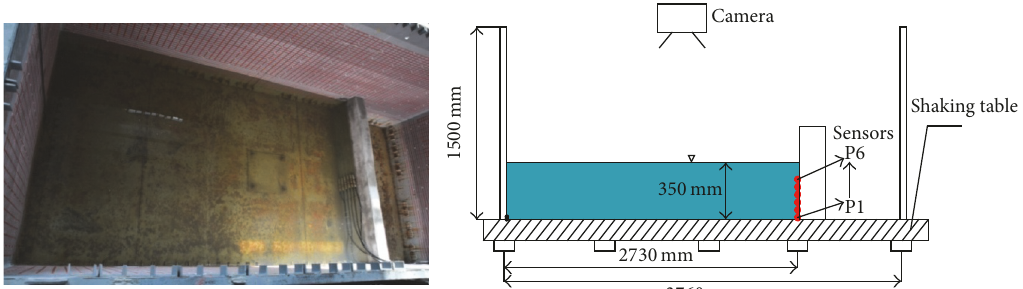
Figure 2: Image and schematic diagram of the pulsating water pressure sensor positions.